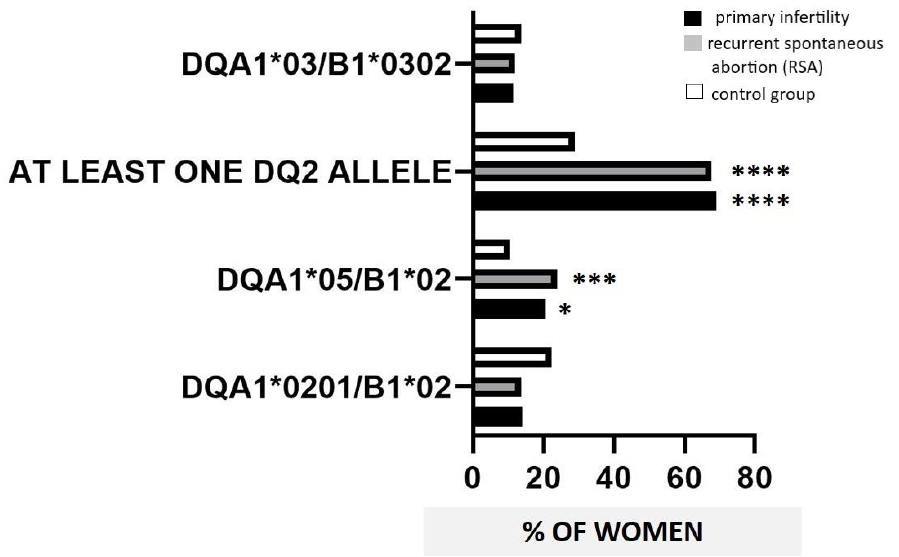
Figure 1. HLA distribution in the study population. Black bars, primary infertility; grey bars, recurrent spontaneous abortion (RSA); white bars, control group. DQA1*03 with DQB1*0302 defined “HLA-DQ8 alleles positivity”. The notation “at least one DQ2 allele” described the occurrence of at least one of the following alleles: DQA1*0201, DQA1*05, and B1*02. HLA-DQ2 allele positivity defined the presence of at least one of the combinations: DQA1*0201/B1*02 and DQA1*05/B1*02. A significantly higher prevalence of at least one DQ2 allele was revealed in infertile and RSA women than in controls. HLA-DQ2 positivity as DQA1*05/B1*02 showed a higher prevalence in infertile and RSA women compared with controls. Chi-squared test or Fisher’ exact test were used to compare groups (* p < 0.05; *** p ≤ 0.001, **** p ≤ 0.0001 compared with